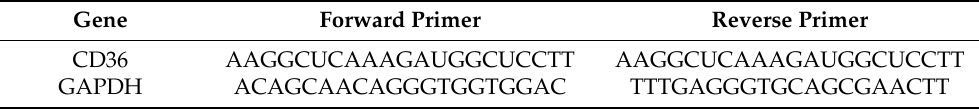
Table 1. List of primers and their sequences used in this study.